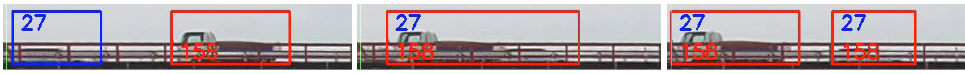
Figure 8. Image sequence of lane overlap between right-going vehicle (ID 27) and left-going vehicle (ID 158) before, during, and after the lane overlap. Traffic count data during the duration of lane overlap are discarded from the evaluation to ensure more representative data of respective vehicles.